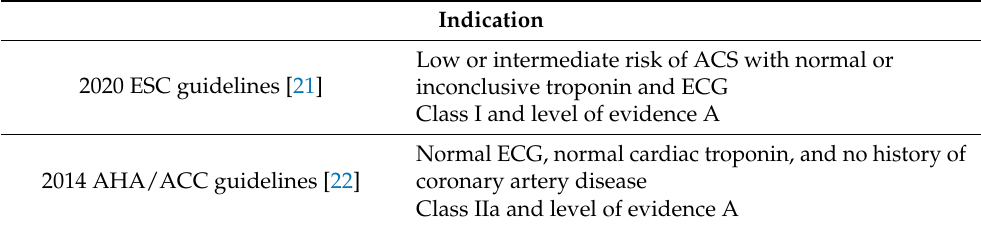
Table 1. Guidelines for the use of coronary CTA in patients with possible acute coronary syndrome (ACS) presenting without ST